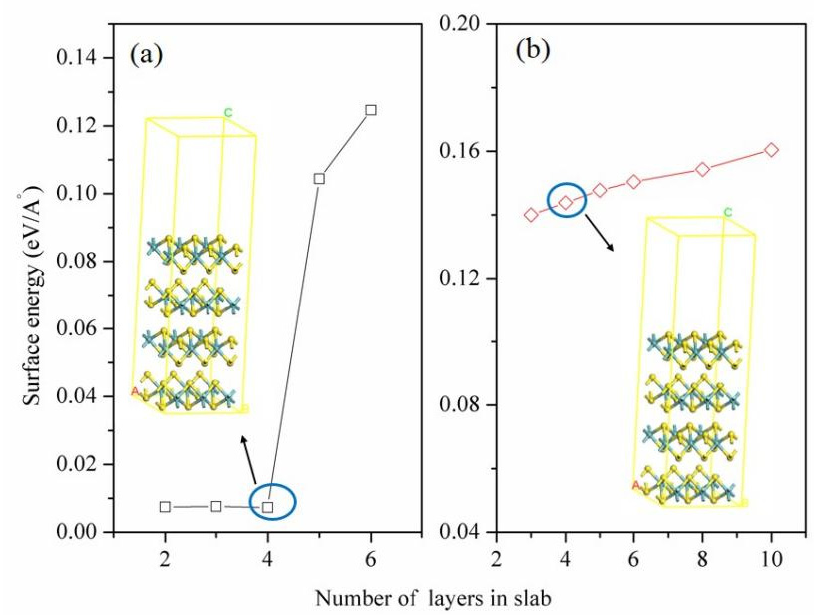
Figure 8. Effect of the layer on surface energy of molybdenite (001) surface ( a ) and (100) surface ( b ).